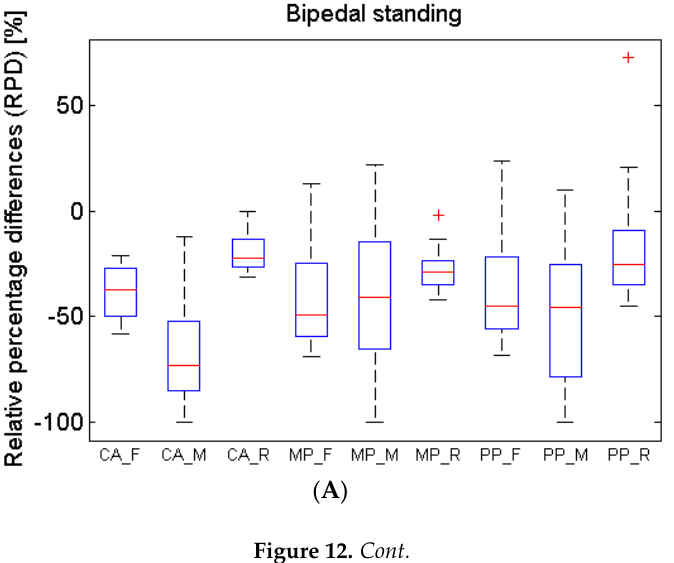
Figure 12. Cont. Figure 12.